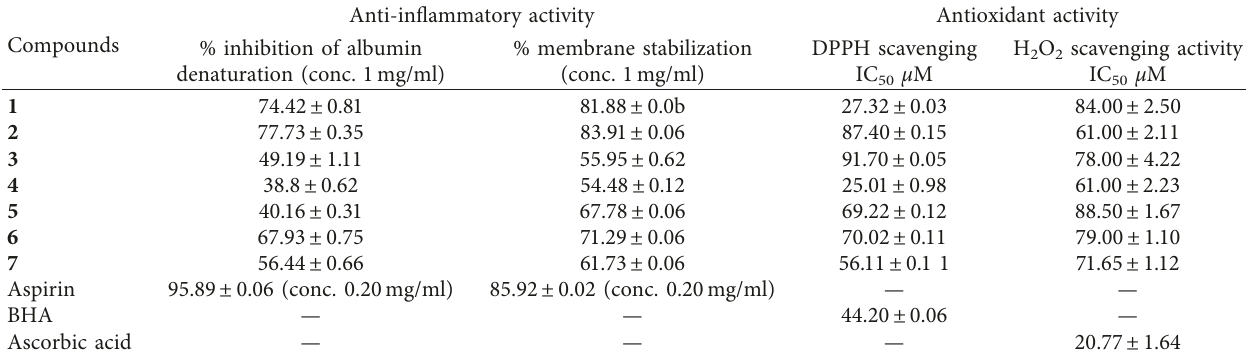
Table 2: Anti-inflammatory and antioxidant activities of products 1–7 . Anti-inflammatory Compounds